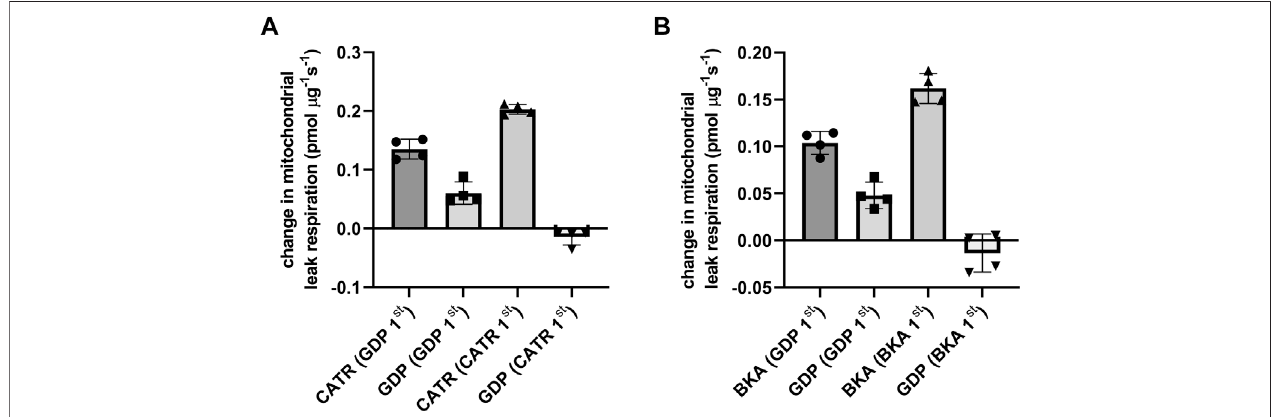
FIGURE1| Inhibitororderspeci fi cANT-andUCP-dependentleakrespirationweremeasuredinisolatedratkidneymitochondriaandde fi nedasthechangeinleak respiration by adding the ANT speci fi c inhibitor CATR locking ANT into c-conformation and the UCP inhibitor GDP during mitochondrial leak state in presence of pyruvate,malateandoligomycin.BeforeANTandUCPinhibition,leakmediatedrespirationwasinducedbyarachidonicacid.Theorderofinhibitionisstatedunderneath the x-axis. (A) Inhibitor order speci fi c ANT and UCP dependent leak respiration using CATR and GDP. (B) In a separate experiment with similar conditions, ANT inhibitor BKA (locking ANT in m-conformation) was used.